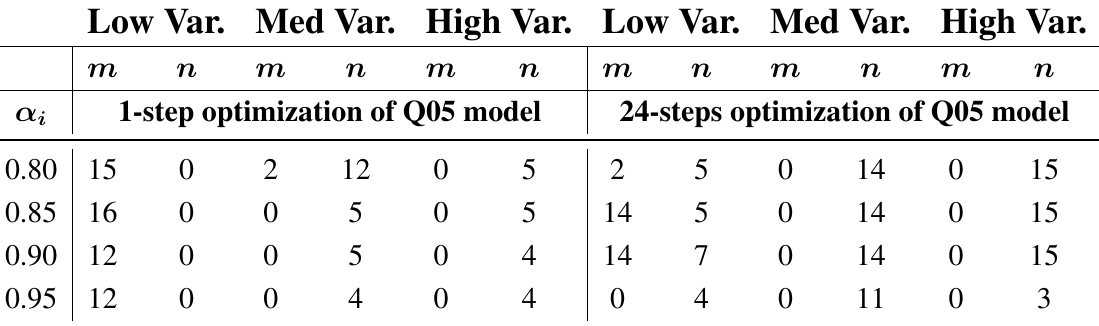
Table 6. 1-step and averaged over 24-steps CFS optimization results for the Q95 model